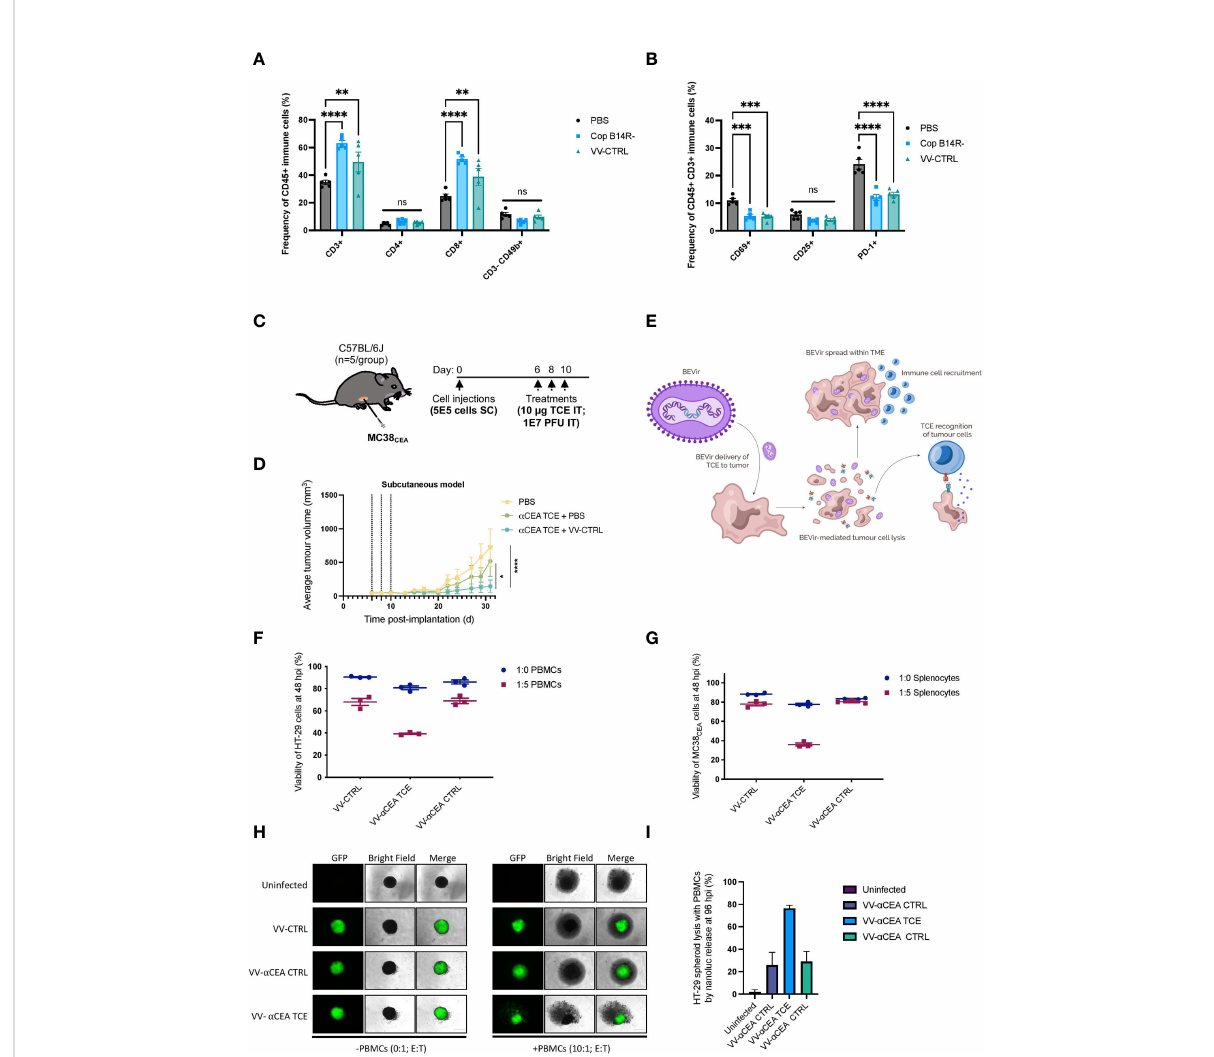
FIGURE 2 TCEs can activate T cells recruited to the tumour microenvironment by oncolytic vaccinia virus. (A) Two doses of vaccinia B14R-deleted (Cop B14R-) or oncolytic VV-CTRL, but not PBS control, both led to recruitment of CD8-positive T cells into MC38 WT tumours at 5 days post- intratumoural injections. In contrast, NK cells (CD3- CD49b+) were not recruited into tumours. Results show the frequency of CD45+ immune cells in % ± SEM, as determined by fl ow cytometry; Two-way ANOVA. (B) Virally recruited T cells did not express CD69 or CD25 activation markers, and T cells also did not express PD-1 as a marker of T cell exhaustion at this time post-infection. Results show the frequency of CD45 + CD3+ immune cells in % ± SEM, as determined by fl ow cytometry; Two-way ANOVA. (C) C57BL/6J mice bearing MC38 CEA